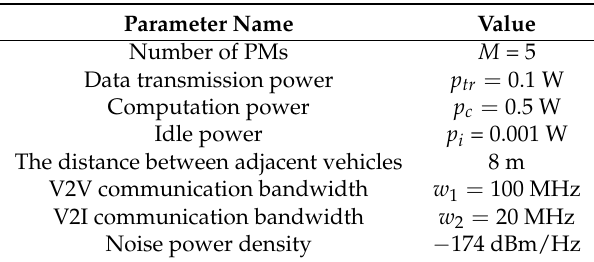
Table 2. Simulation parameters.